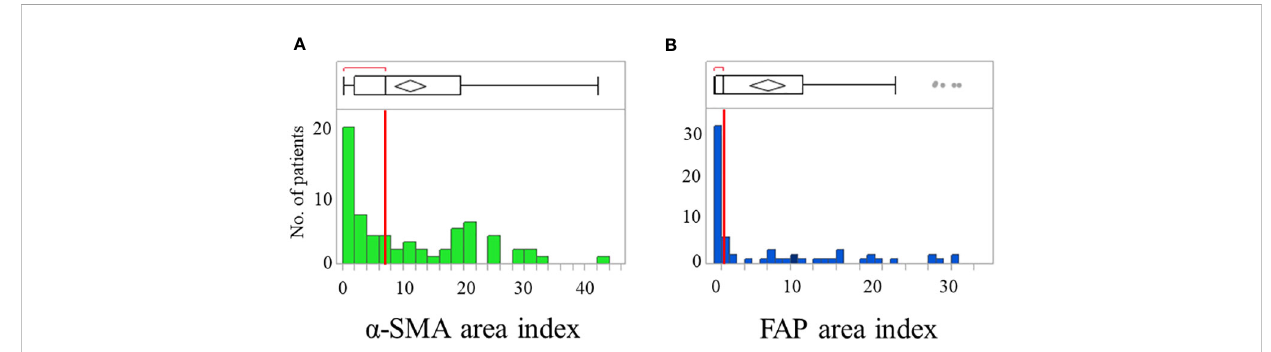
FIGURE 1 Distribution of patients showing a -smooth muscle actin ( a -SMA) (A) and fi broblast activation protein (FAP) (B) area index. Box plots show median with the interquartile range; whiskers give the